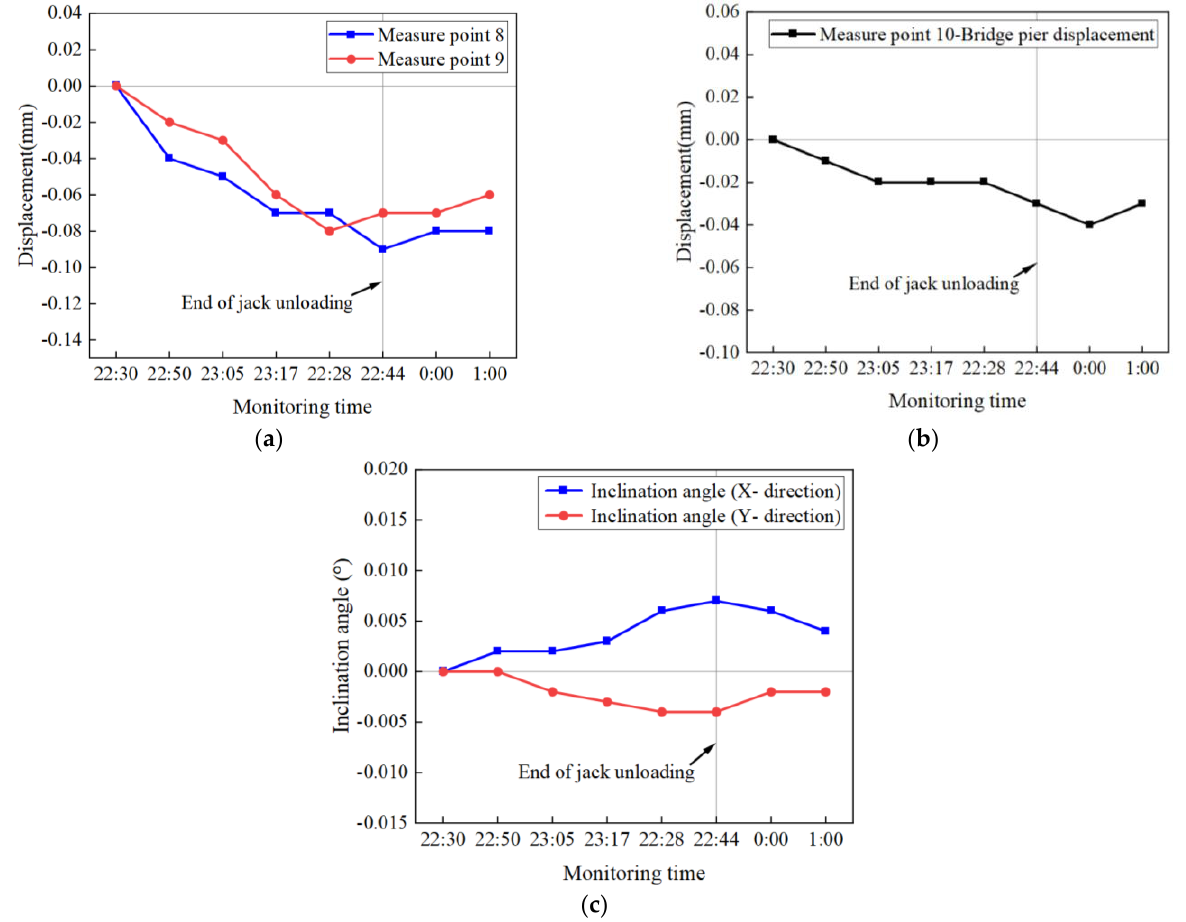
Figure 12. Displacement monitored during unloading stage: ( a ) displacement of underpinning beam; ( b ) displacement of bridge pier; and ( c ) pier inclination.